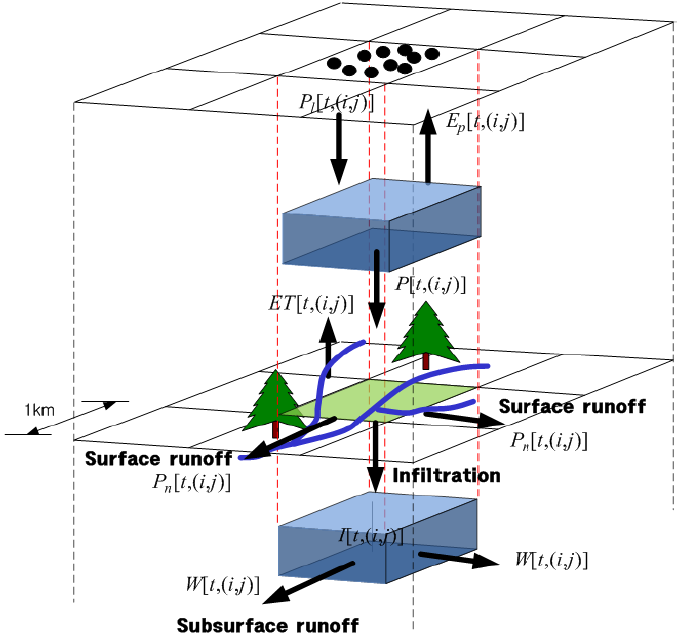
Figure 3. Conceptual diagram of cell water balance [32].